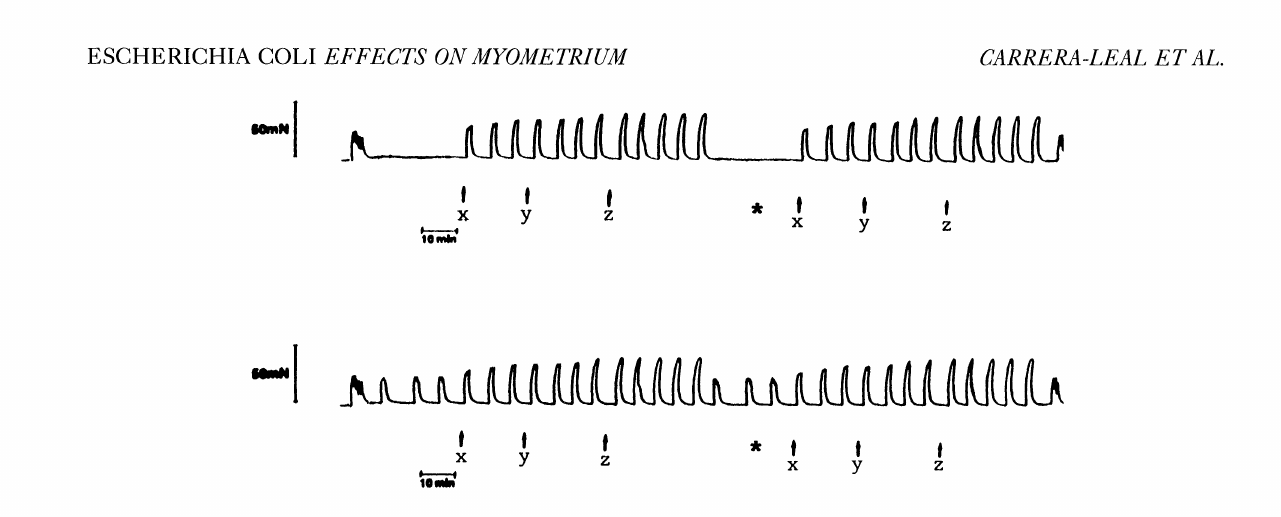
Fig. I. Analog tracing of the effect of the cumulative addition of oxytocin on the contractility of isolated human myometrial strips with and without spontaneous activity after and before incubation with toxin or vehicle. Doses of agonist were added at the points indicated by arrows. Note high potassium stimulus at the beginning and at the end of each experiment. Incubation time is indicated by an